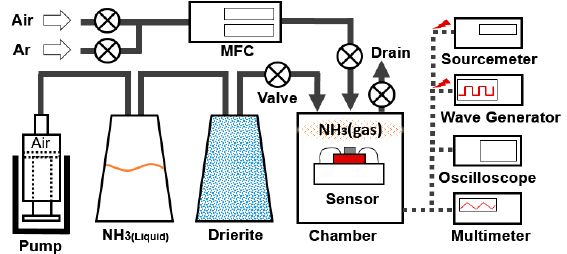
Figure 5. Experimental setup to flow target gas and measure the output from the gas sensor. MFC: mass flow controller. mass flow